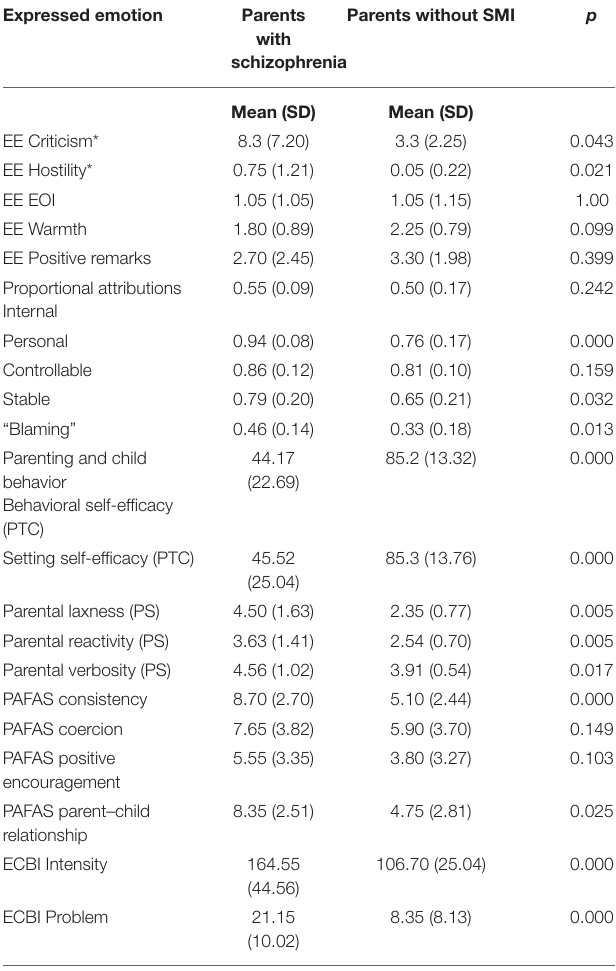
TABLE 3 | Differences in expressed emotion, attributions, parenting, and reports of child behavior between groups. Parents with Parents without SMI Expressed emotion Parents schizophreniaParents without schizophrenia with